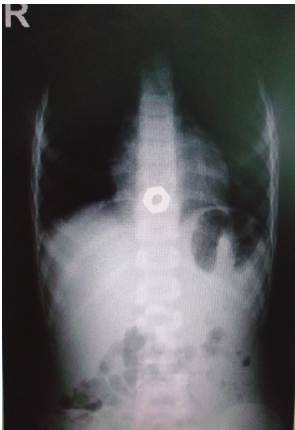
Figure 1: Foreign body at the cardia of a 6-year-old